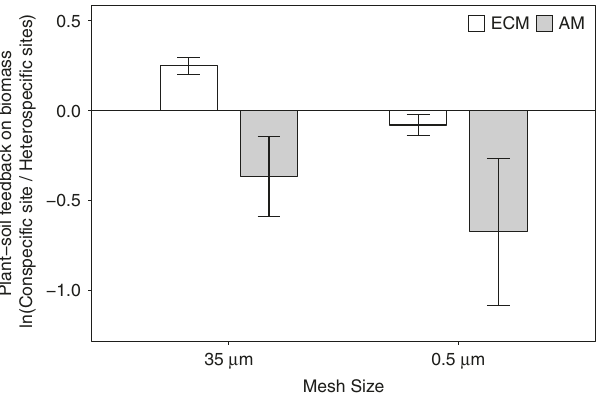
Fig. 4 Overall plant – soil feedbacks on seedling growth for ECM and AM species. White: ECM tree species; grey: AM tree species. Values represent mean log response ratios± s.e.m. ( n = 3 independent focal species for each mycorrhizal type), which compared seedling mean biomass of in-growth cores at conspeci fi c ( n = 6 biologically independent seedlings) vs. heterospeci fi c ( n = 30 biologically independent seedlings) sites. Source data are provided in a Source data fi le. treatments (Fig. 4; Supplementary Fig. 2, right panels), and the negative effects were less in 0.5 µm than 35 µm cores (Fig. 4, grey bars).